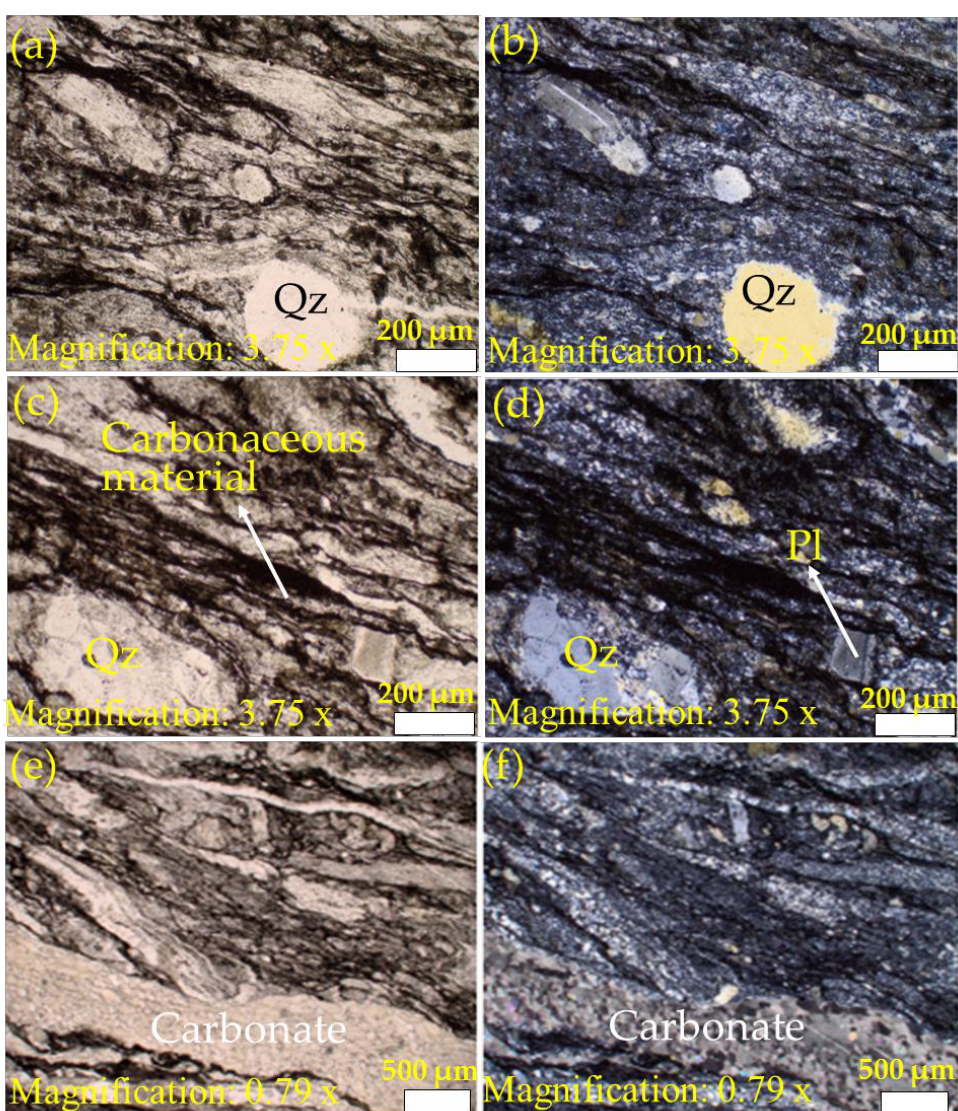
Figure 4. Petrographic analysis of the studied samples at room temperature, 22 ◦ C (Qz and Pl represent quartz and plagioclase, respectively). Images ( a , c , e ) were taken using plane-polarized light, while ( b , d , f ) were captured using cross-polarized light. Image ( a ) (PPL) and image ( b ) (CPL) display flaser texture in reworked crystal-rich rhyolitic tuff marked by cataclasis, granulation, shearing, and foliation. Images ( c , d ) are close views of images ( a , b ) displaying blastoporphyritic texture. Note quartz and plagioclase phenoclasts are set in a recrystallized fine-grained felsic matrix. Images ( e , f ) display partial to intense granulation and recrystallization of quartz (Qz) and plagioclase (Pl). Additionally, note dark lamellae of carbonaceous material that follows foliation planes and commonly wrap around phenoclasts. Images ( g , h ) show intense shearing and crushing of groundmass and stretching and elongation of phenoclasts parallel to the deformation plane. Additionally, note fractures with quartz and carbonate fillings. PPL: plane-polarized light; CPL: cross-polarized light.